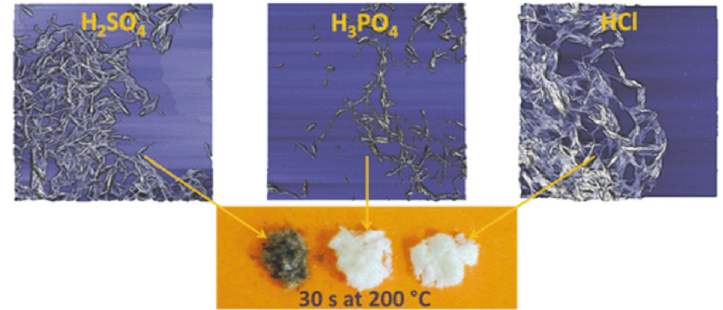
Figure 2: Schematic diagram of thermal stability contrast of CNCs from sulfuric acid hydrolysis, hydrochloric acid hydrolysis, or phosphoric acid hydrolysis